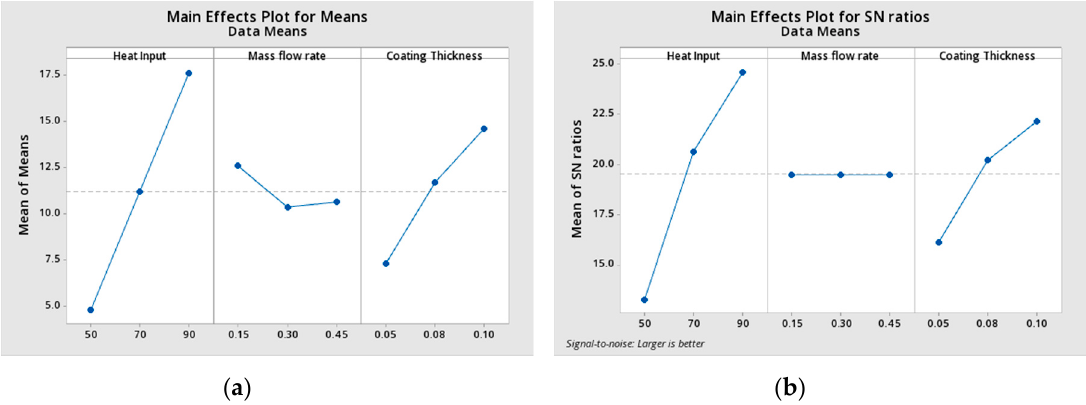
Figure 15. Taguchi Analysis for Rate of heat transfer Versus Heat Input, Mass Flow Rate and Coating